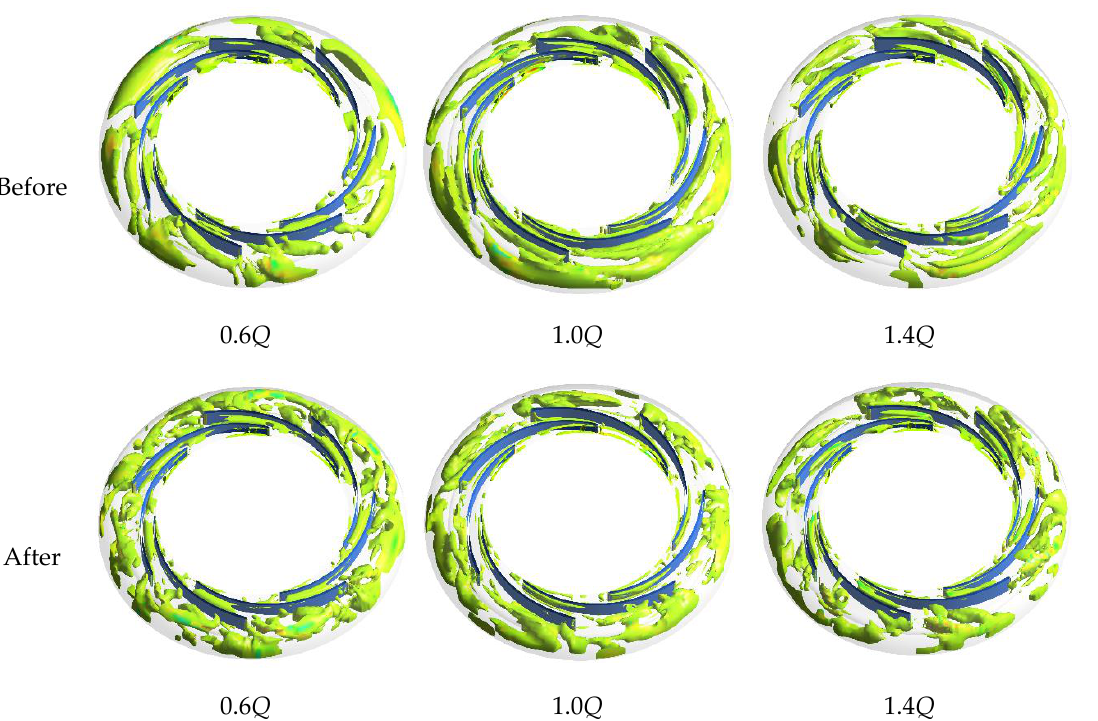
Figure 20. Vorticity distribution of the first-stage impeller before and after optimization.